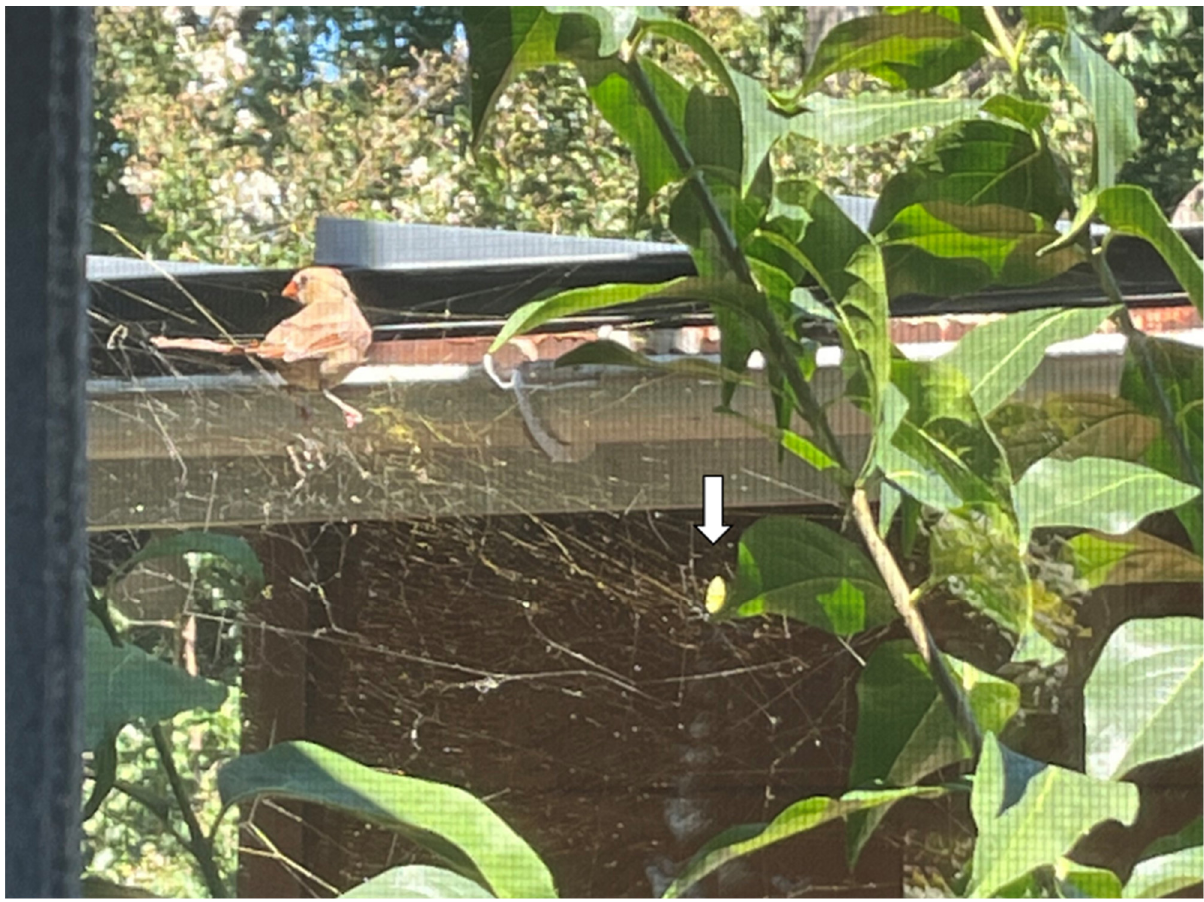
Figure 2. Kleptoparasitism behavior by a northern cardinal ( Cardinalis cardinalis ), observed on 13 September 2022 in Atlanta, GA (Fulton Co.). The cardinal perched on the top of the jor ō spider web (which did not break) and proceeded to pick off trapped insects from the web. The spider (arrow) moved to the edge of the web during the encounter. The bird flew off after ~2 min, seemingly without effort or entanglement. The web remained intact and was present the following day. Photo taken by A. Schronce (through a screen door).